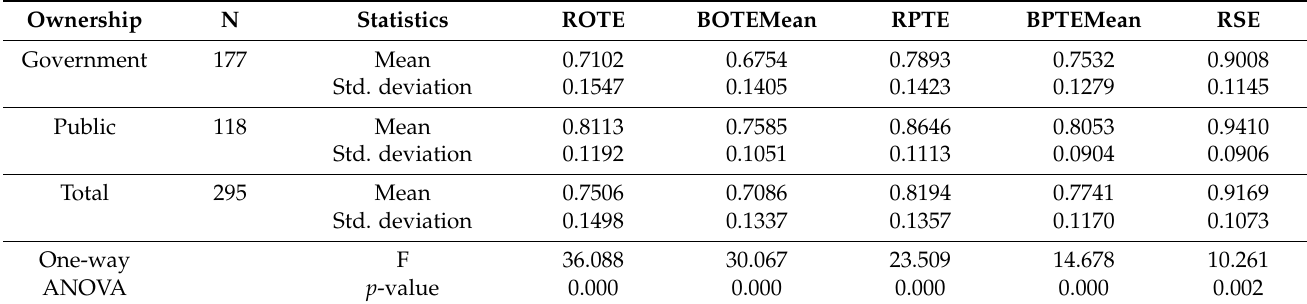
Table 4. ANOVA test: results of comparison of power-generating companies per ownership type.